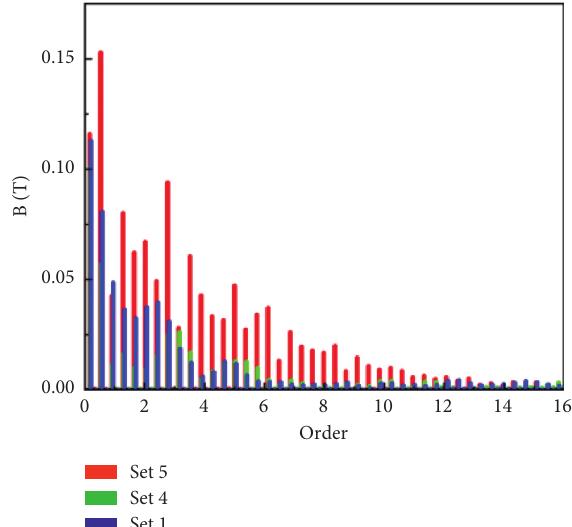
Figure 9: The FFT diagram of radial magnetic density at the optimal parameter